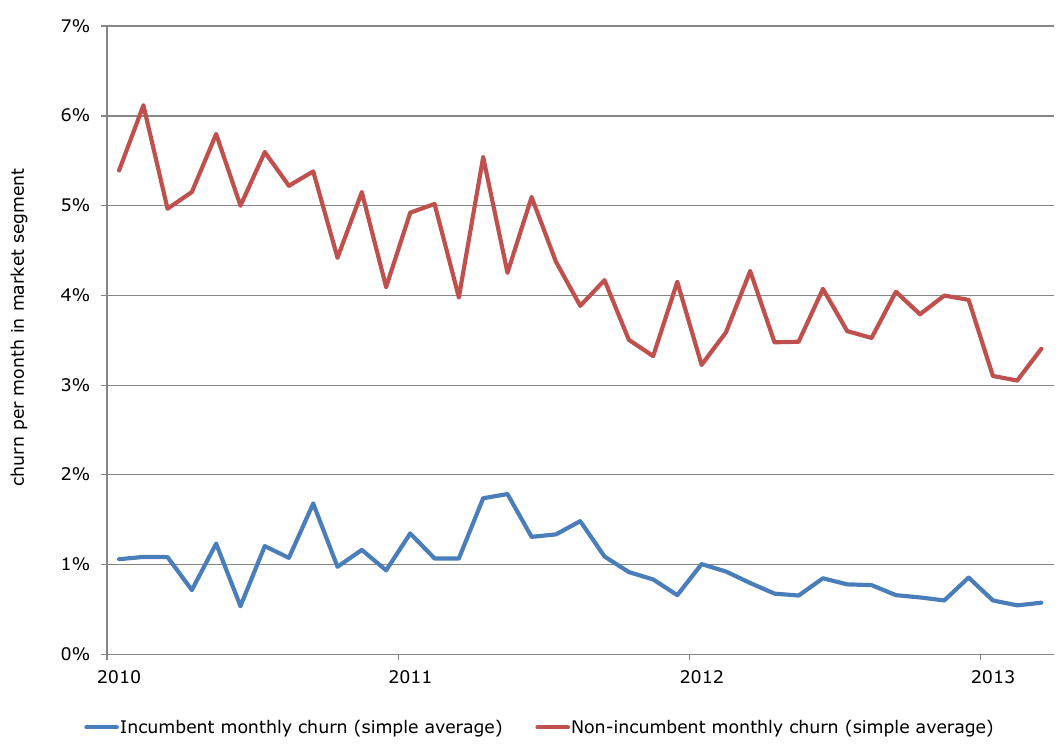
Figure 24: Average Centrica single-fuel gas customer switching versus single-fuel gas customer switching for other legacy